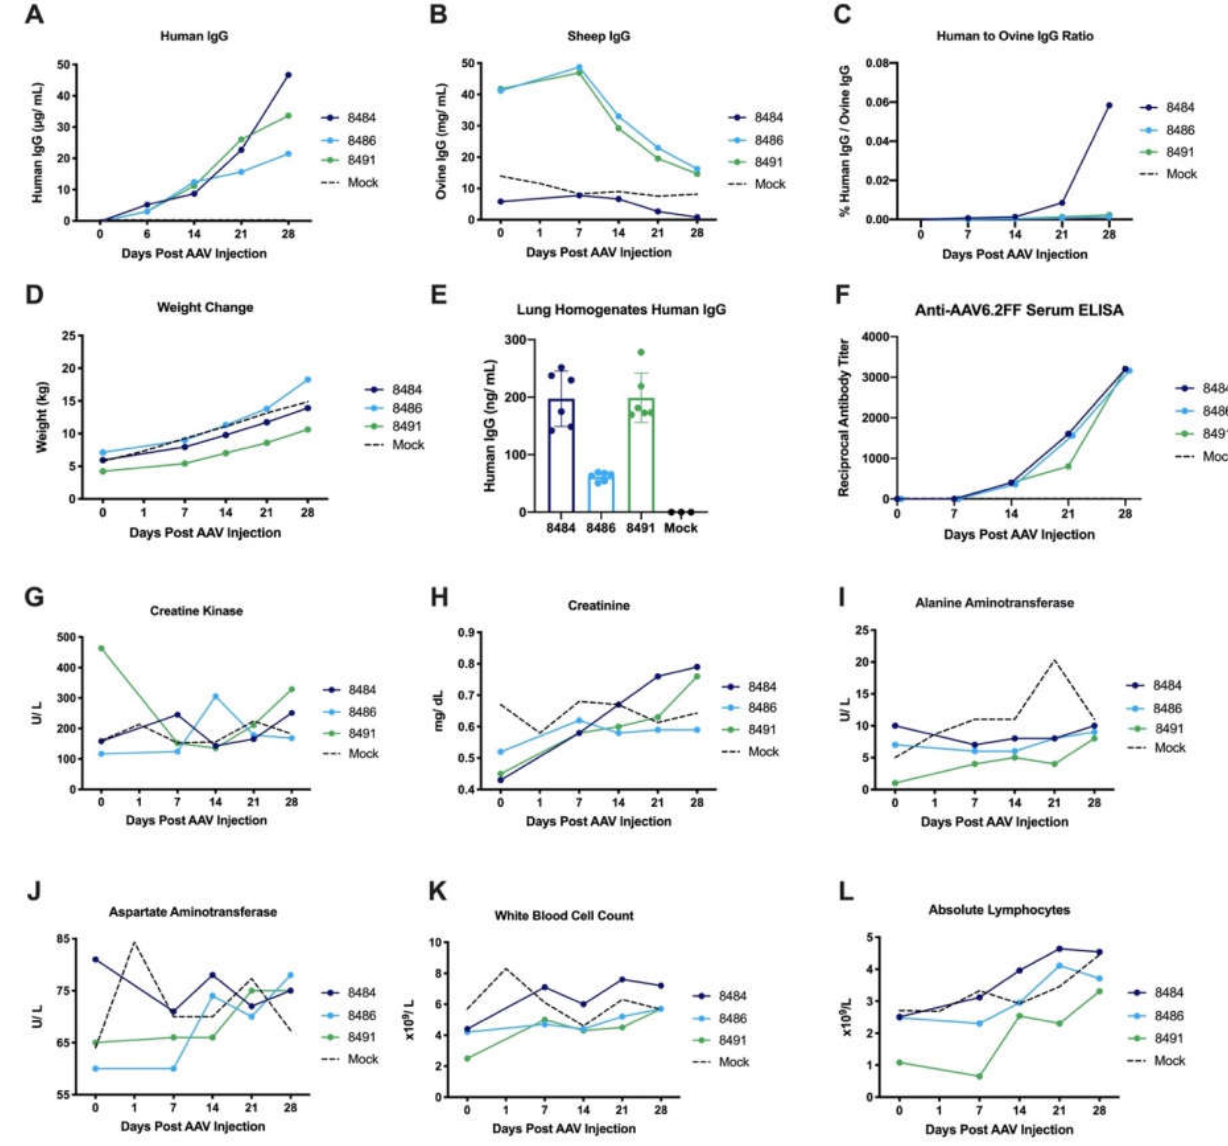
Figure 3. Findings of the ovine AAV6.2FF-31C2 feasibility study. Three 2-week-old lambs were administered 5x10 12 VG/ kg of AAV6.2FF-31C2 by IM injections to the rump. Aged-matched controls ( n = 3) were administered PBS IM. Weekly blood samples were collected and analyzed for plasma ( A ) hIgG concentration, ( B ) oIgG concentration and ( C ) the calculated ratio of hIgG to oIgG is displayed. ( D ) Sheep were weighted weekly throughout the in-life phase of the study. ( E ) Lung homogenates at endpoint (two sample sites per animal) were analyzed for hIgG concentration. ( F ) Anti-AAV6.2FF capsid antibodies were monitored weekly. Plasma and whole blood samples were analyzed for ( G ) creatine kinase, ( H ) creatinine, ( I ) alanine aminotransferase, ( J ) aspartate aminotransferase, ( K ) white blood cells and ( L ) absolute lymphocytes. The black dotted line represents the average value for the three control sheep.